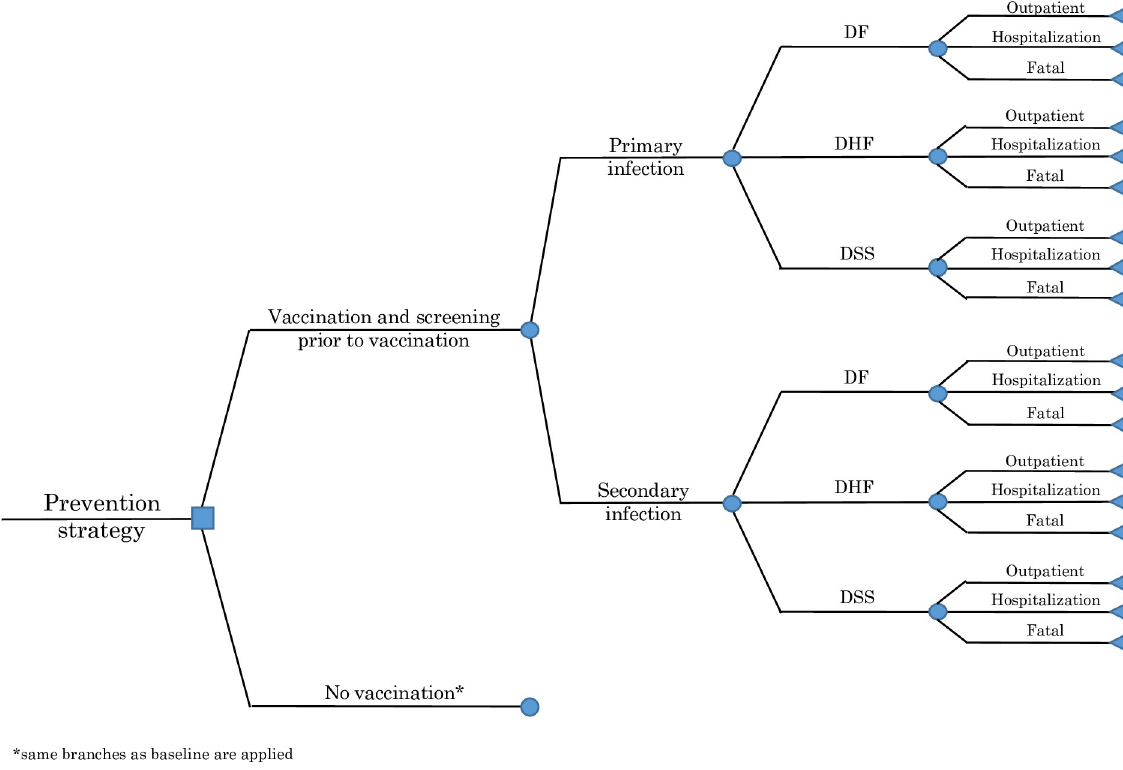
Fig 1. Decision tree